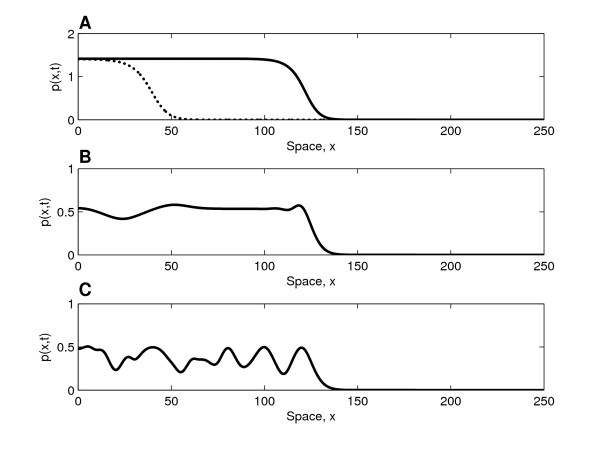
Solution profiles prior to therapy. Three snapshots of the spatial domain showing how the tumour cell density varies in space at the point in time (t = 200 in dimensionless units) at which chemotherapy is applied; the results of chemotherapy in these cases are presented in Figure 7. (A) Solid line depicts the cell density at the point in time at which chemotherapy is applied (t = 200 in dimensionless units), while the dotted line shows it at approximately 145 days before start of therapy (t = 100 in dimensionless units). From the spatial spread that occurs between these time points (82.15 dimensionless spatial units, corresponding to 0.29 cm in dimensional terms) we calculate the wave speed to approximately 0.002 cm/day. Parameter values: η0 = 10.0, dp = 0.5, ds = 4.8 × 105, Ds = 2.0 × 105, Dv = 1, hs = 1.6 × 106, sβ = 0.4, σp = 3.7 × 104 with δ = 9 (case A), δ = 11 (case B) and δ = 11.6 (case C). Numerical solution obtained with Δx = 25/900 for the domain size L = 250 with initial conditions (p(0, 0), v(0, 0), s(0, 0), c(0, 0)) = (0.01, 1, 10/12, 0) and (p(x, 0), v(x, 0), s(x, 0), c(x, 0)) = (0, 1, 10/12, 0) for x: 0 <x ≤ 250.